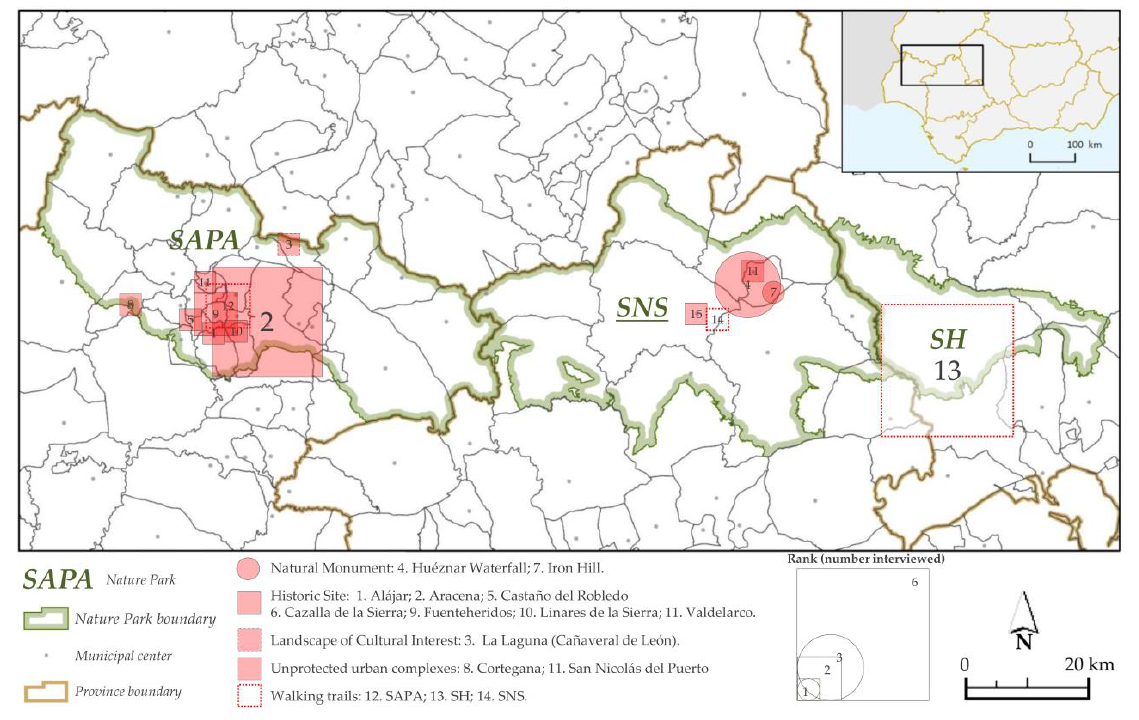
Figure 8. Overload, according to the informants. Source: Interviews, 2021; authors ’ elaboration.